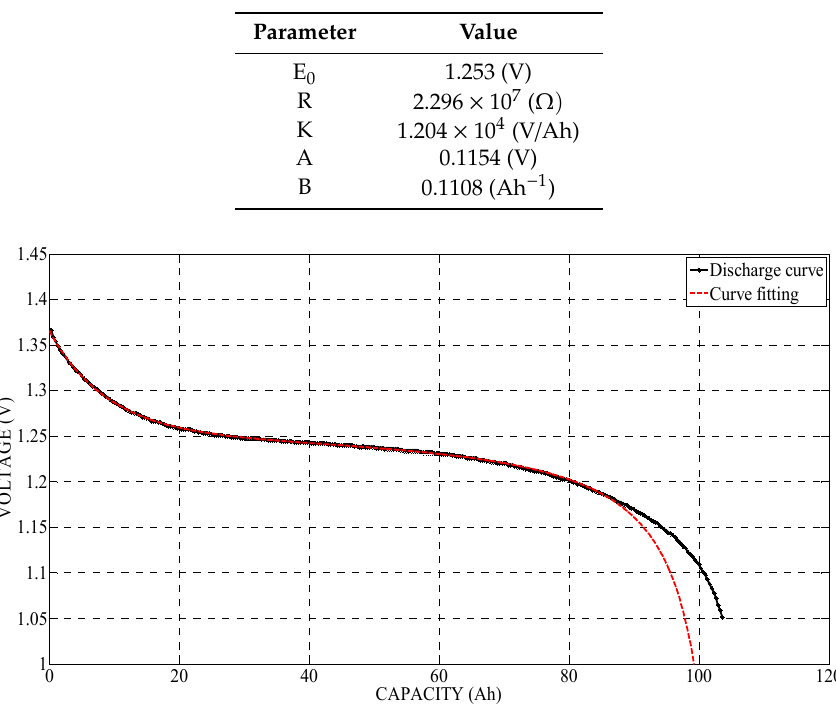
Figure 12. Curve fitting for 0.2 C discharge curve.